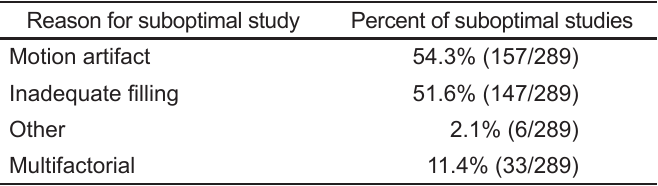
Table 1. Reasons for suboptimal CTPA studies.